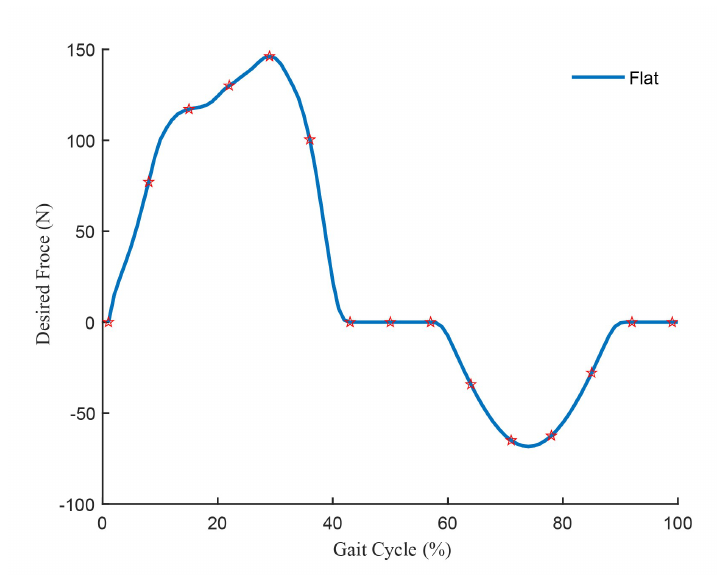
Figure 4. Human hip joint biological torque curve when walking on the ground.